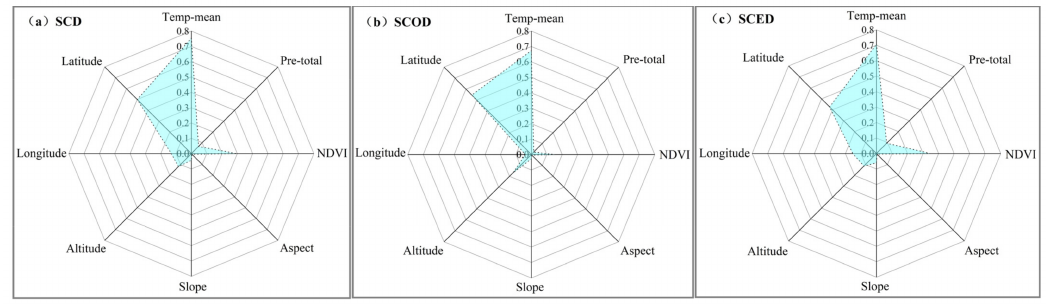
Figure 12. Effects of meteorological and geographic factors and the NDVI on snow phenology. ( a ) SCD, ( b ) SCOD, ( c ) SCED. Note: p <